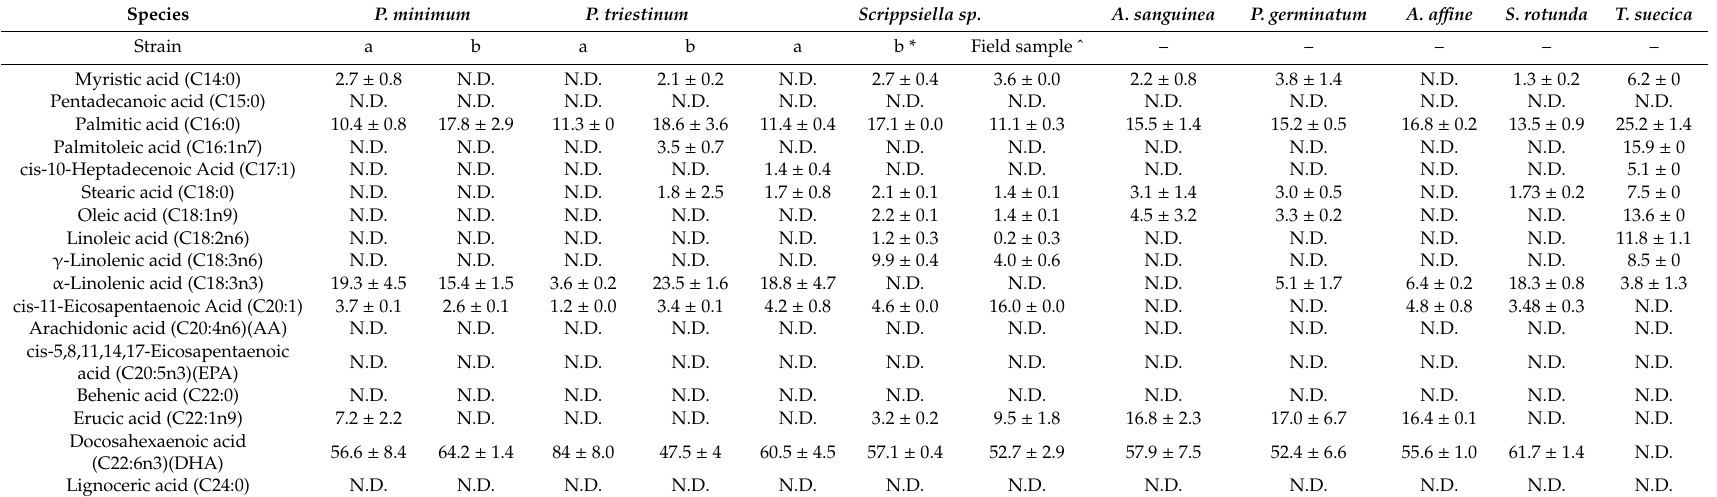
Table 4. Fatty acid composition (% of total fatty acid methyl esters (FAME)) in selected algal strains. Data expressed as mean ± SD (n = 3). Species P. minimum Myristic acid (C14:0)